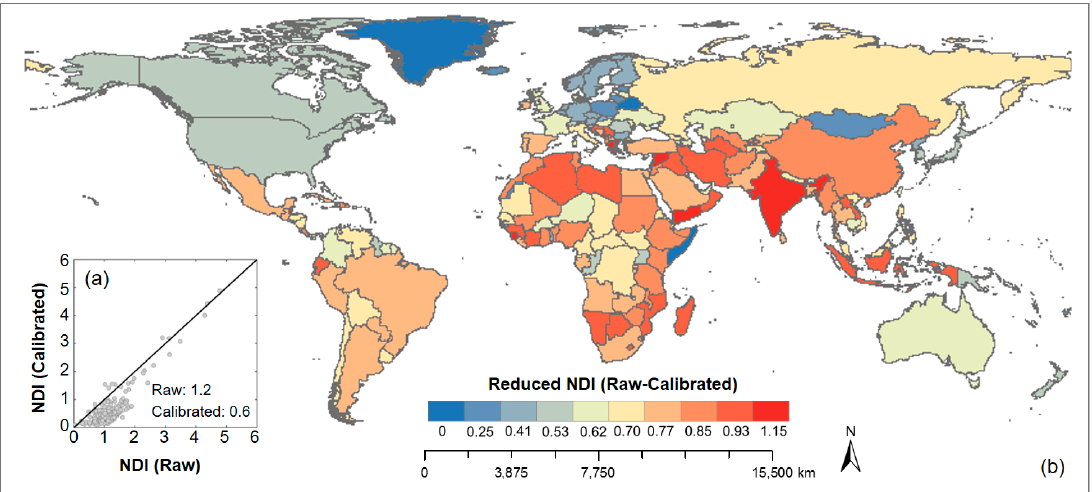
Figure 10. Normalized difference index (NDI) derived from the stepwise calibrated and raw NTL series ( a ) and their difference among countries ( b ). The black line is the 1:1 line.